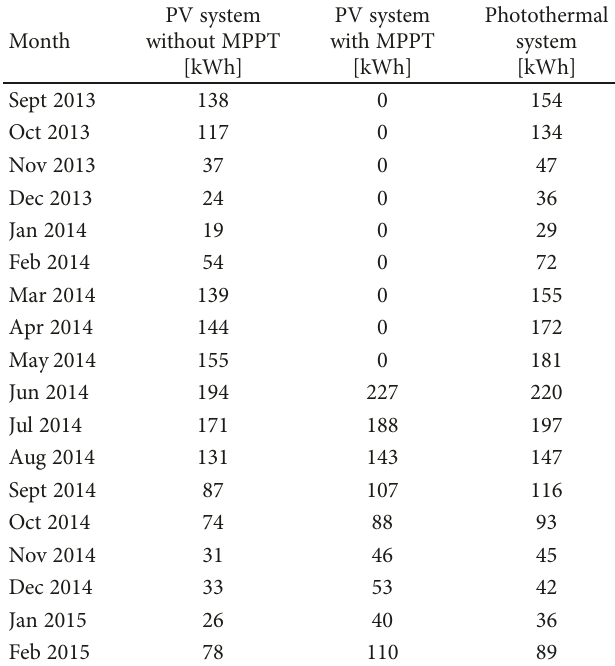
Table 6: Experimental evaluation of solar water heating